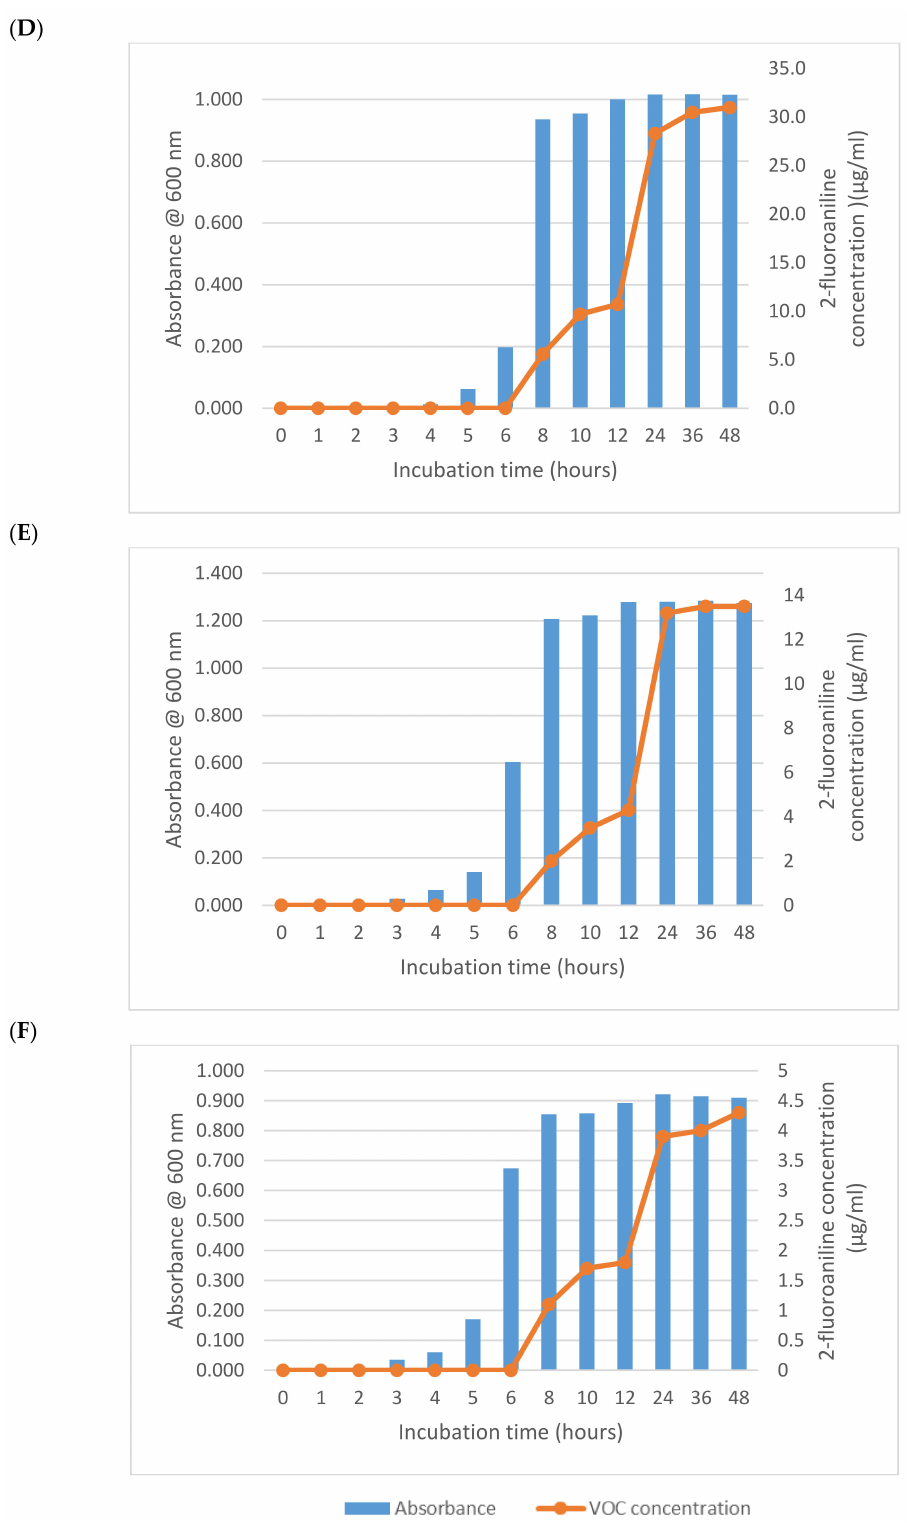
Figure 1. Growth and 2-fluoroaniline production for selected bacteria at 37 ◦ C in brain heart infusion (BHI) broth. Initial inoculum 1 × 10 6 CFU / mL, 1-fluoro-2-nitrobenzene concentration 100 µ g / mL. ( A ) E. coli (NCTC 12241), ( B ) S. typhimurium NCTC 74, ( C ) P. aeruginosa NCIMB 8295, ( D ) B. subtilis NCTC 8236, ( E ) S. aureus NCTC 11939 and ( F ) E. faecium NCTC